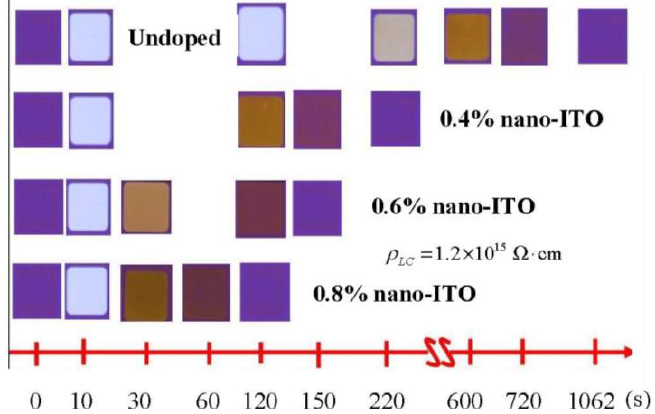
Figure 12. Relaxation of the sticking images for the samples with LC of 1.2 × 10 15 Ω∙cm under an attack of 5 V pulses. In such tests, the cells were designed in the normally black